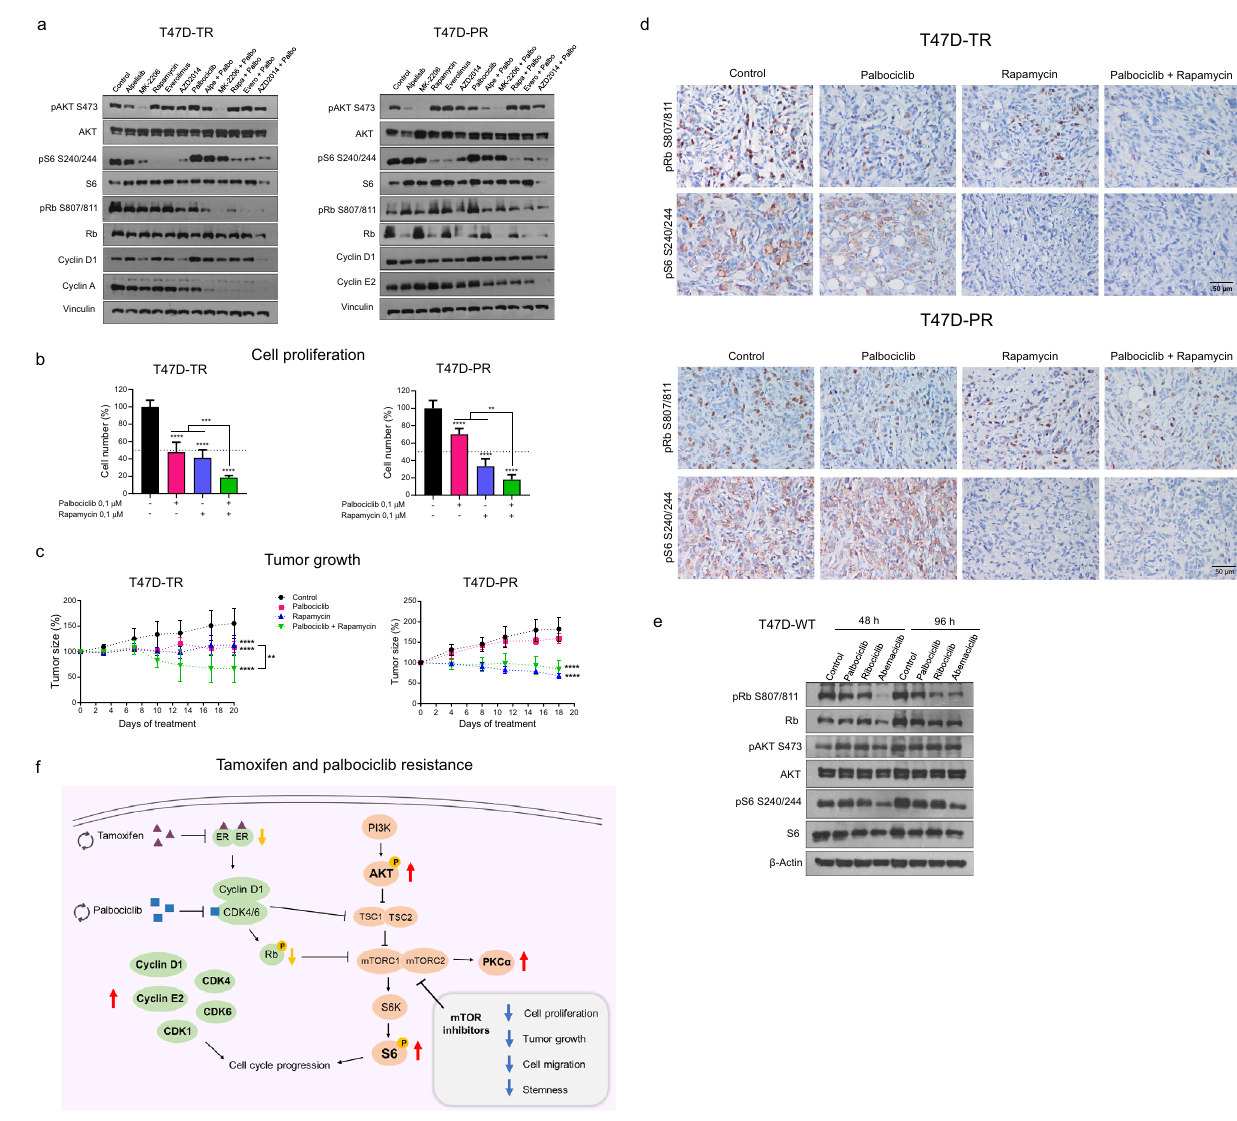
Figure 4. Combined inhibition of mTOR and CDK4/6 to overcome resistance. ( a ) Effect of palbociclib in combination with PI3K/AKT/mTOR inhibitors on cell cycle proteins and PI3K/AKT/mTOR activation. T47D-TR and T47D-PR cells were treated with alpelisib (0.1 µM), MK-2206 (0.1 µM), rapamycin (0.1 µM), everolimus (0.1 µM), AZD2014 (0.1 µM) and their combinations with palbociclib (0.1 µM) for 30 h. Protein lysates were analyzed by immunoblot with the indicated antibodies. ( b ) Effect of palbociclib in combination with rapamycin on cell proliferation. T47D-TR and T47D-PR cells were treated with palbociclib (0.1 μM), rapamycin (0.1 µM) and the combination for 7 days. **p < 0.01, ***p < 0.001, ****p < 0.0001. Data represent mean ± SD, one-way ANOVA followed by Tukey’s test (independent replicates n = 3, with 4 experimental replicates in each group). ( c ) Effect of palbociclib in combination with rapamycin on tumor growth. 8 × 10 6 T47D-TR or T47D-PR cells were inoculated subcutaneously in the lateral flank of NSG mice. Tumor sizes were relativized to their size before starting treatment. Tumors were treated with palbociclib (25 mg/kg 5 times per week, subcutaneously), rapamycin (17.5 mg/kg 2 times per week, by intraperitoneal injection) or the combination for 18–20 days. **p < 0.01, ****p < 0.0001. Data represent mean ± SD, two-way ANOVA followed by Tukey’s test (independent replicates n = 2, with 3 to 6 experimental replicates in each arm of treatment). Representative curve of two in each variant. ( d ) Effect of palbociclib in combination with rapamycin on pRb and pS6 levels in tumors. Immunohistochemistry for pRb Ser807/811 and pS6 Ser240/244 was performed on tumors treated with palbociclib, rapamycin, and the combination. Representative images of stained tumor sections. ( e ) Effect of different CDK4/6 inhibitors on PI3K/AKT/mTOR activation. T47D-WT cells were treated with palbociclib (0.1 µM), ribociclib (0.1 µM), abemaciclib (0.1 µM) or vehicle for 48 or 96 h. Protein lysates were analyzed by immunoblot with the indicated antibodies. ( f ) Summary of the results found in T47D and MCF-7 resistant cell variants. Red/yellow arrows represent upregulation/downregulation of phosphorylation or protein expression. Blue arrows represent downregulation of cellular processes. Original blots/gels are presented in Supplementary Material, unprocessed western blots